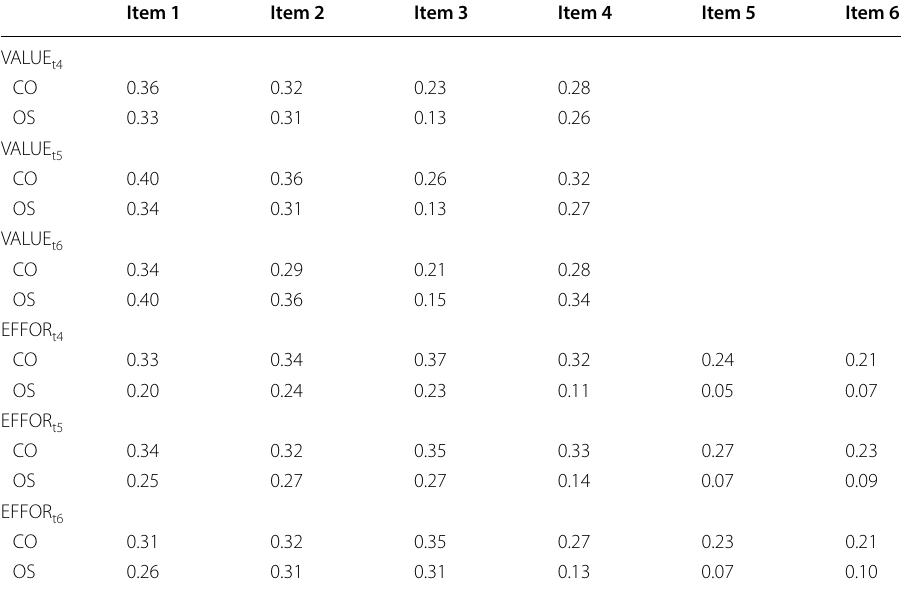
Table 2 Consistency and occasion‑specificity of the two test motivation constructs Item 1 Item